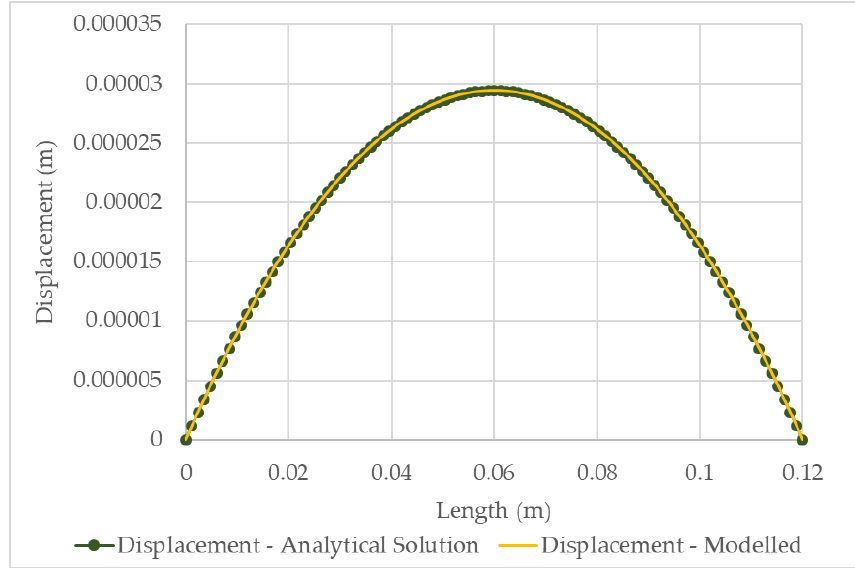
Figure 4. Verification study — 1D steady-state solution results for displacement over the length of the specimen.